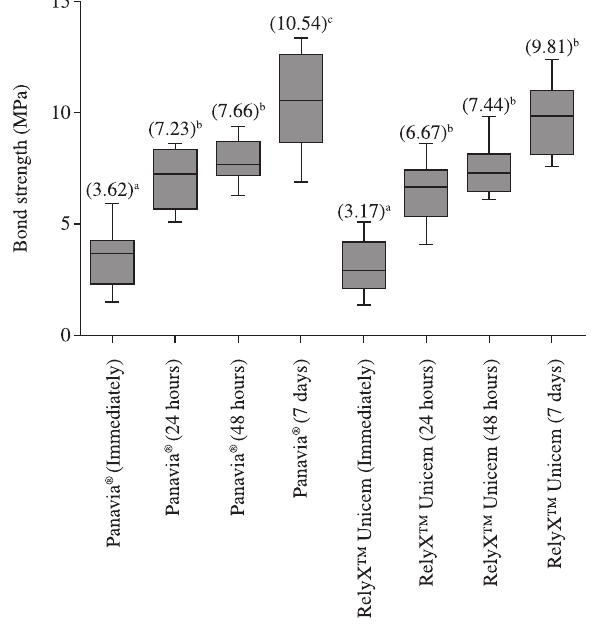
Figure 2. Bond strength values (in MPa) to resin cements used in this study. Different letters (a-c) indicate statistically significant difference at 5% level (Tukey's test; p <